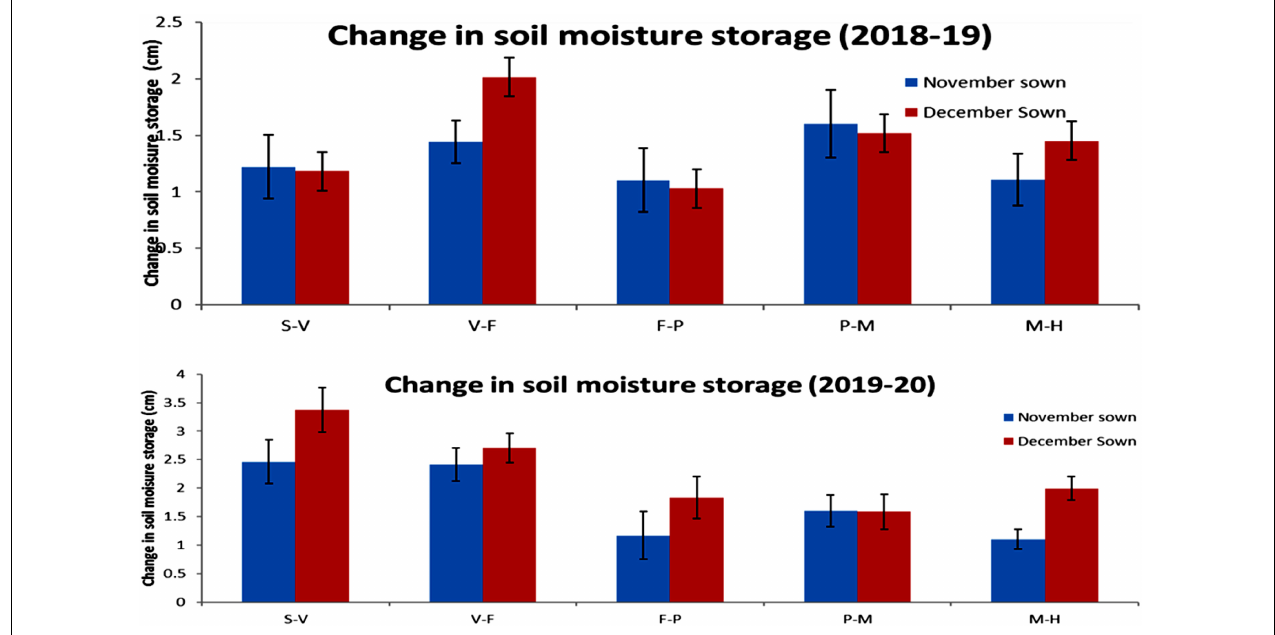
FIGURE 10 | Change in soil moisture storage (0–45 cm soil profile) for different sowing dates in the 2018–19 and 2019–20 lentil cropping seasons. Error bars represent the standard error of the mean. Values are means, and bars represent ± SEM ( n = 3). Different letters indicate significant differences between means. S–V (sowing to the vegetative stage), V–F (vegetative to the flowering stage), F–P (flowering to pod development stage), P–M (pod development to maturity stage), and M–H (maturity to harvest stage). TABLE 5 | Effect of sowing time and zinc, iron, and boron foliar sprays seed nutrients and seed protein. Treatments Fe (mg/100 g) Zn (mg/100 g) B (mg/100 g) Seed protein (%) Late-sown Normal-sown Late-sown Late-sown Normal-sown